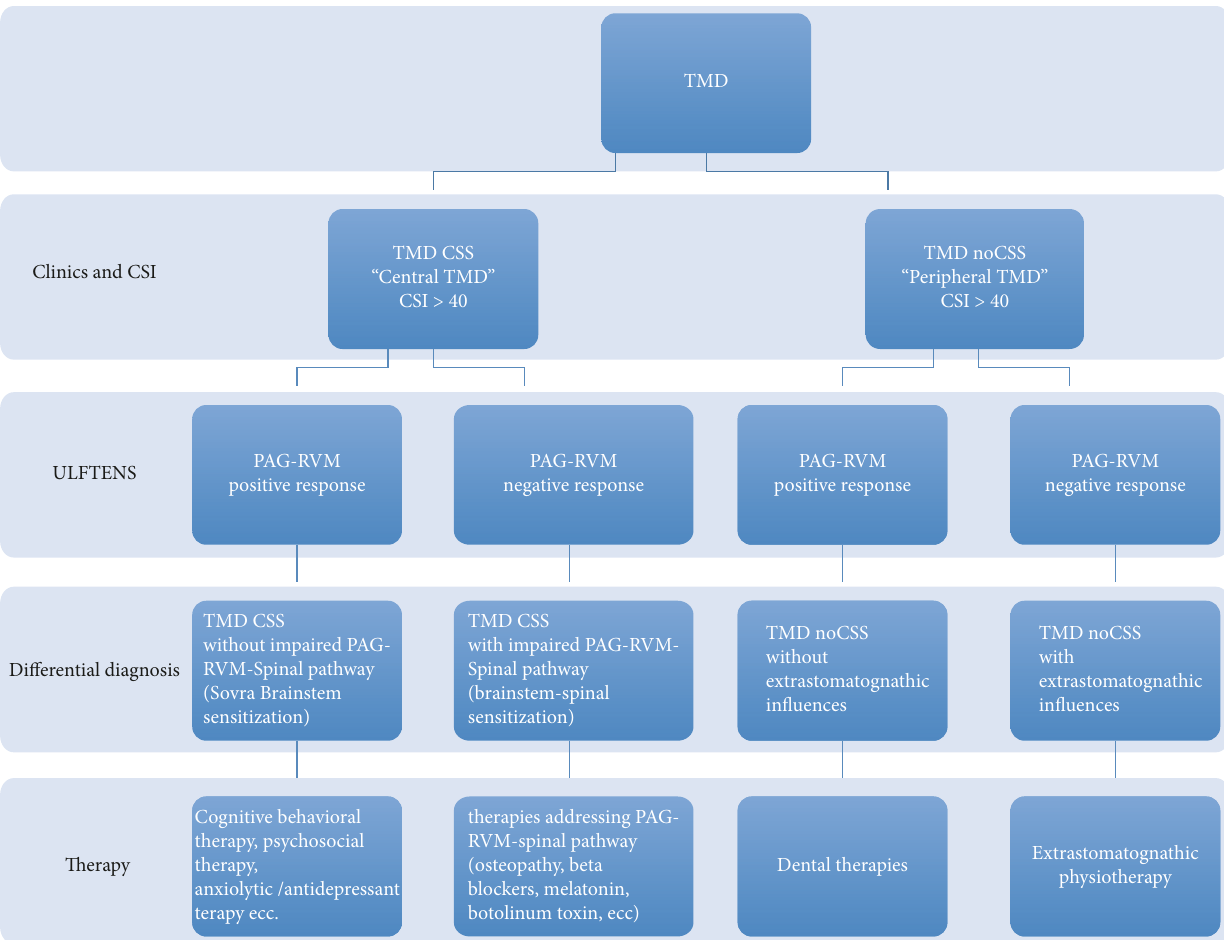
sensory ULFTENS as a “provocation” test on the descending PAG-RVM system. PAG-RVM reacts to sensory ULFTENS as a function of its functional state of normality or CS. In case of normality, ventrolateral PAG and PAG-RVM circuit increase their activity and, among other effects, also induce muscle